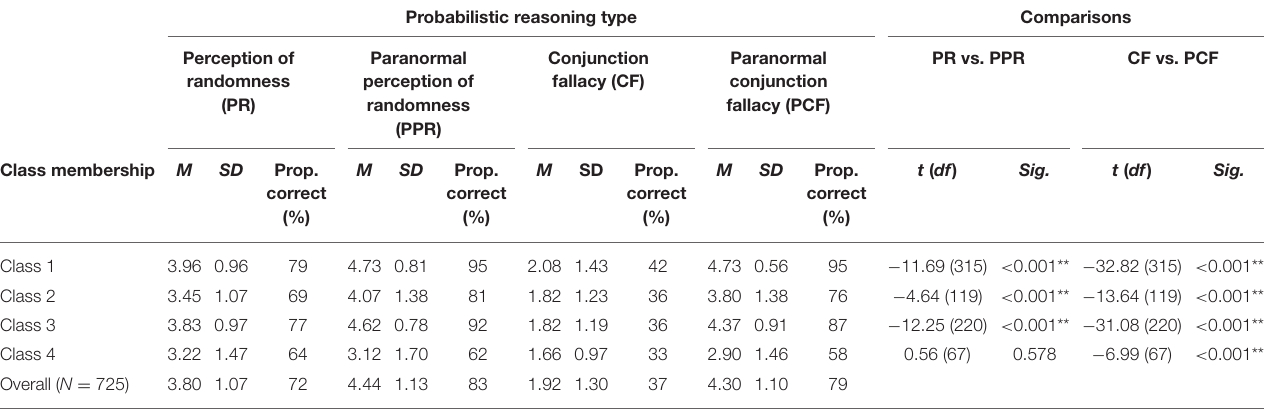
TABLE 5 | Probabilistic reasoning performance as a function of class